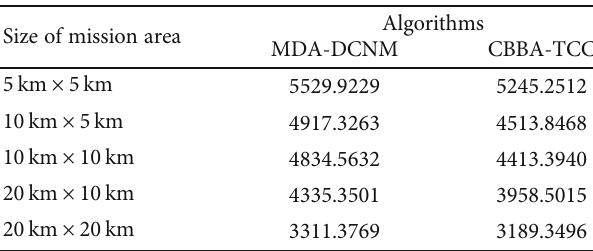
Table 7: Scores of two algorithms under di ff erent mission sizes. Size of mission